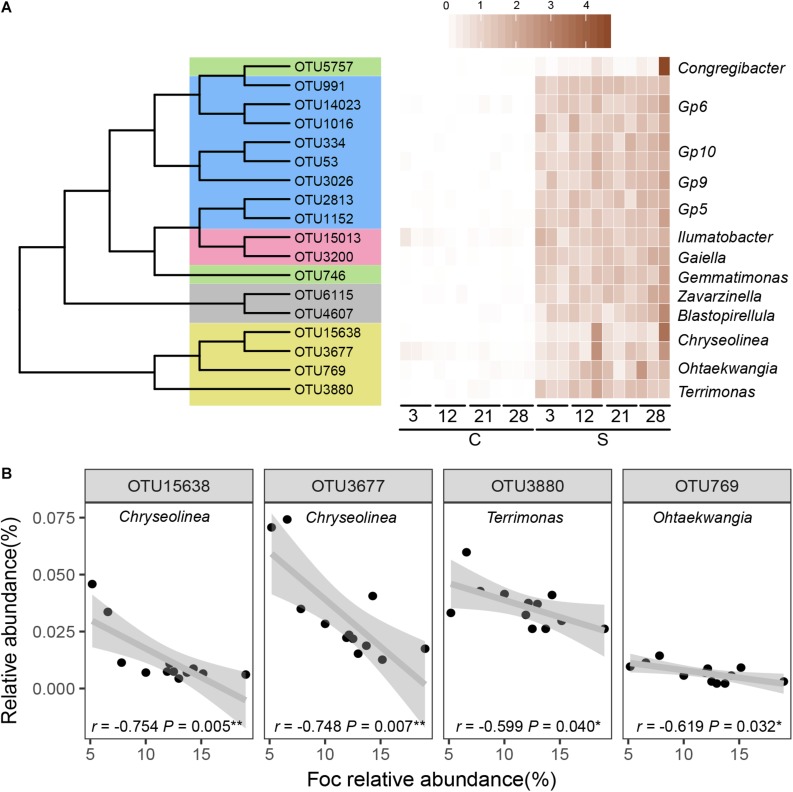
Key OTUs contributed most to the suppressive microbiome. (A) Heatmap displaying the OTUs (with RA > 0.01% at least one time point) significantly negatively (Pspearman < 0.05) correlated with Foc in the suppressive soil based on relative abundance together with matches with an RDP confidence estimate above 0.6 at the genus level. (B) Spearman correlations (r) between relative abundances (RA) of taxa with biocontrol capacity and Fusarium.